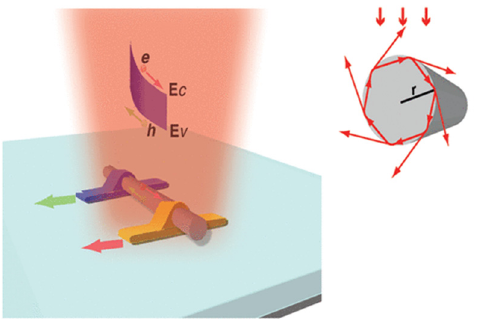
Figure 4. A germanium (Ge) nanowire-based MSM photodetector with asymmetric (one side Ohmic and the other Schottky) metallic contacts.